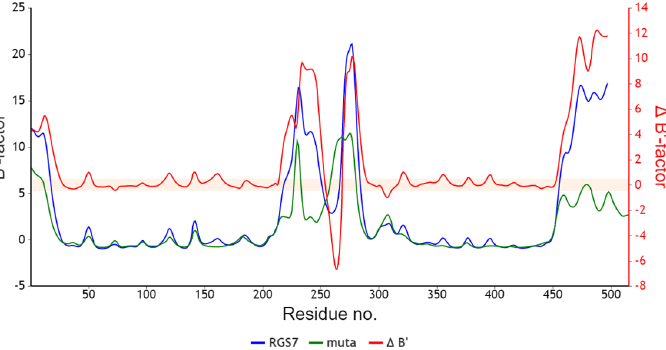
Figure 6. B-factor shows a significant difference between mutant and wild-type RGS7 protein.